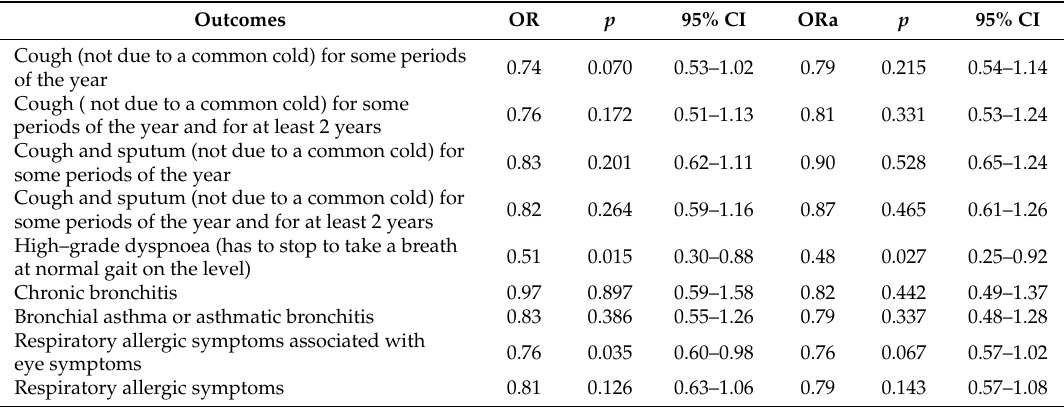
Table 2. Multivariate analysis with logistic regression, related to the distance-based approach. Odds ratios are expressed per 1 km distance of place of residence from the